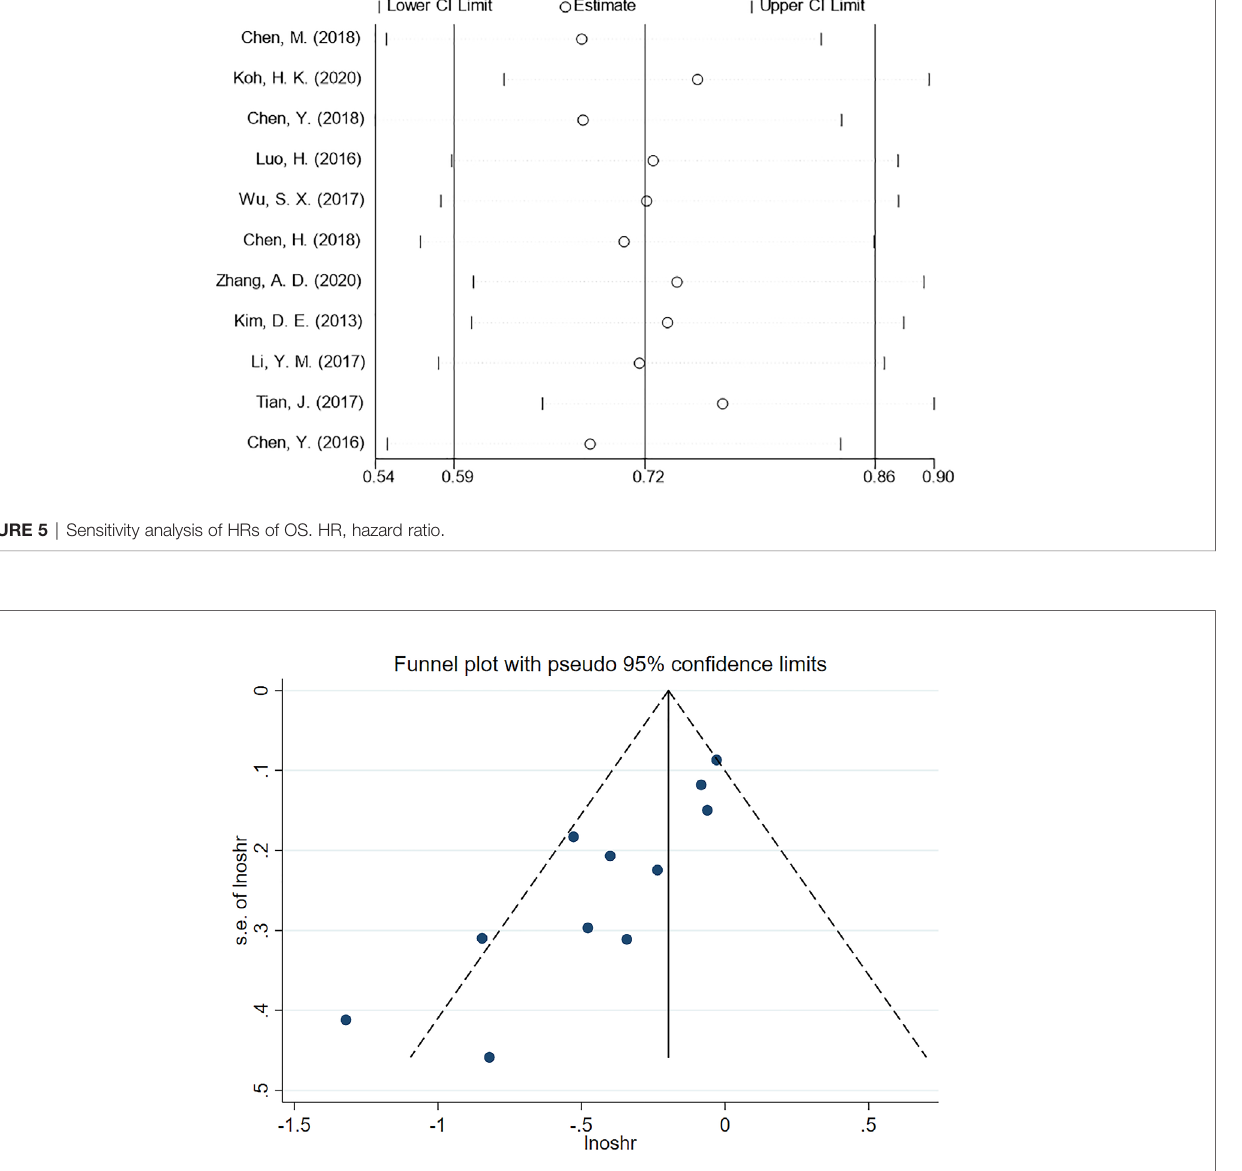
FIGURE 6 | Funnel plot of publication bias for